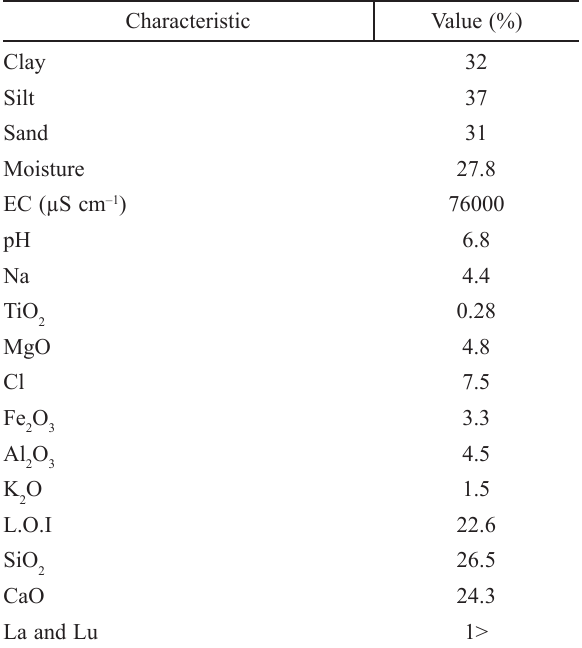
Table 1 – Characteristics of the soil sample along with XRF results